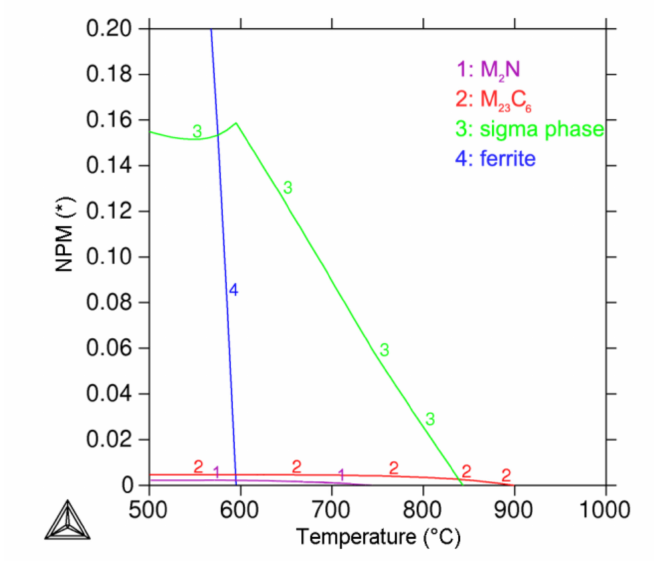
Figure 9. Mole fraction of phases in AISI 316L steel as a function of temperature. The influence of the annealing temperature on the chemical composition of predicted equilibrium secondary phases was calculated using Thermo-Calc software. The change in the chemical composition of M 23 C 6 carbide (Figure 10a) was insignificant in the selected temperature range; however, at higher temperatures, the amount of Fe rose. More sig- nificant differences were observed in the sigma phase (Figure 10b), where the Cr content decreased with increasing temperature, and, conversely, the Mo content increased.